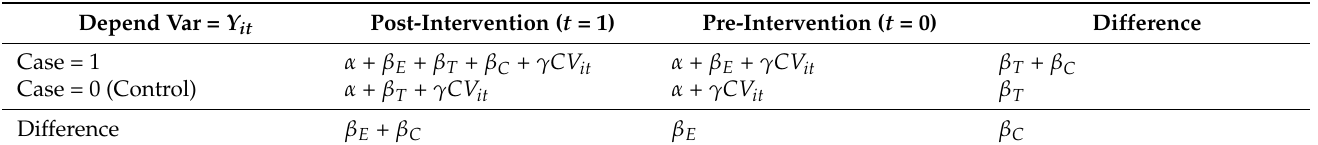
Table 1. Formal parametrization of the DID regression